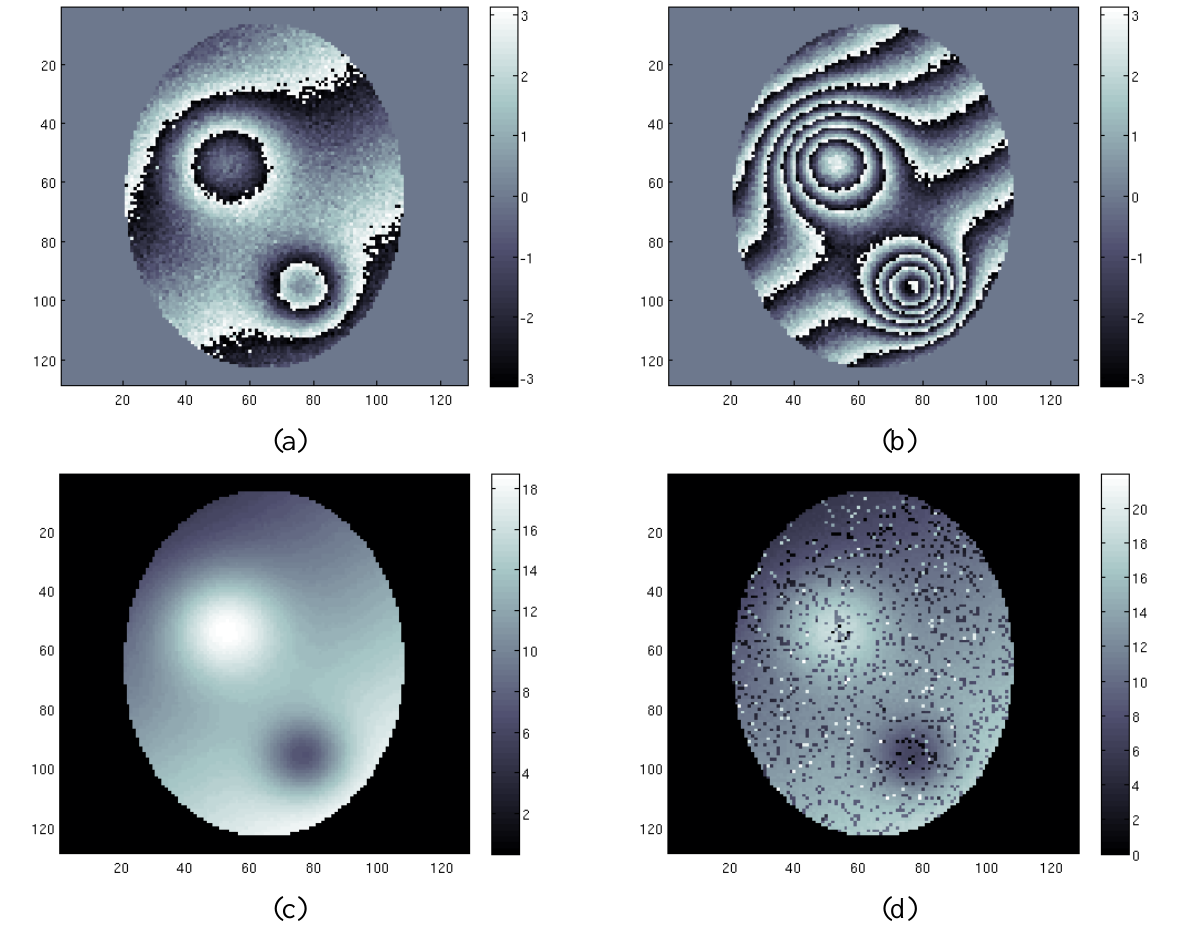
Figure 3. First case study: (a) first phase image, (b) fourth phase image, (c) estimated field map using proposed technique, (d) estimated field map using conventional ML